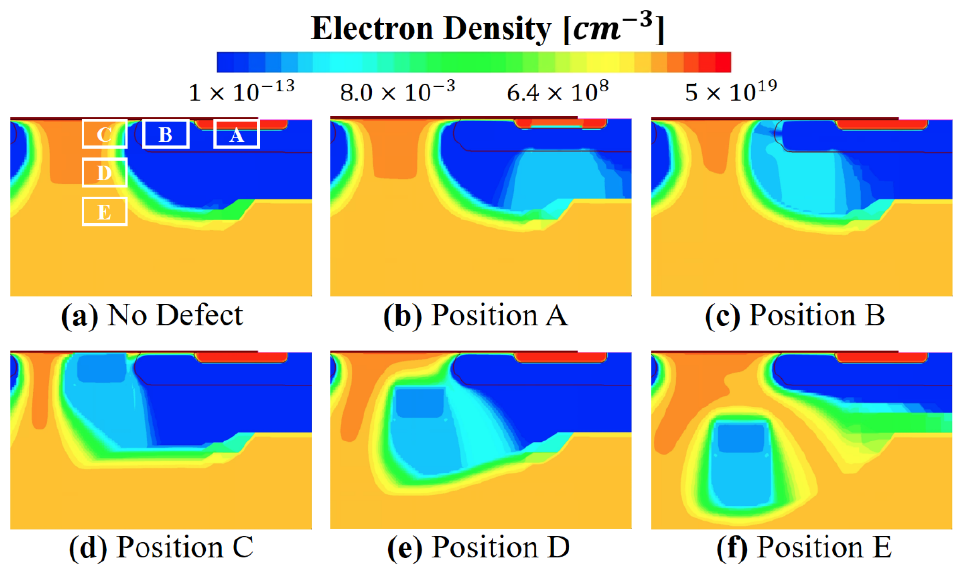
Figure 4. Electron density profiles of SiC MOSFETs ( a ) with no defect and ( b – f ) with accepter-like defects at five different locations. The bias condition is V GS = 14 V and V DS = 20 V. Defect energy level is E C − 1.55 eV.